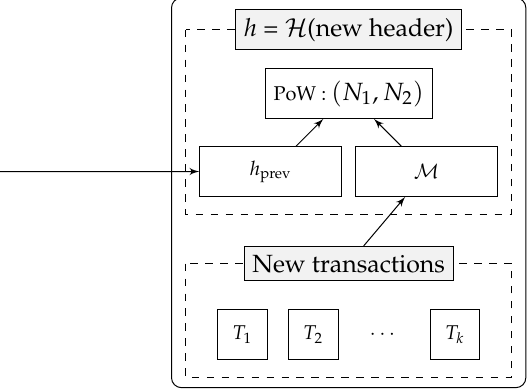
Figure 2. A Standard Block [SB]